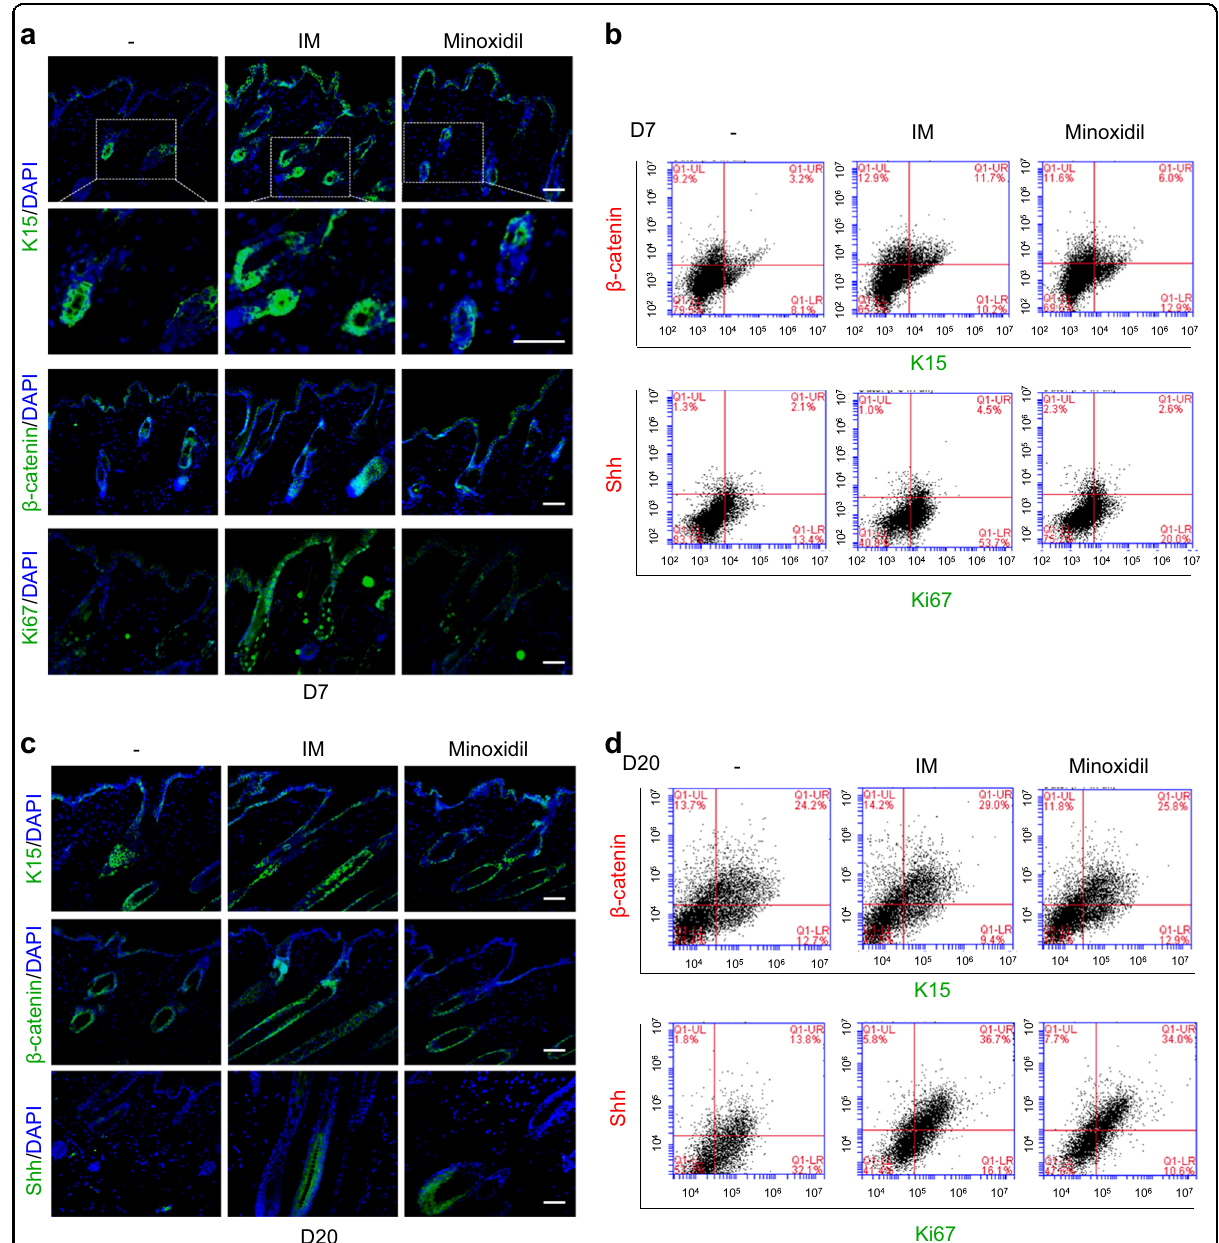
Fig. 5 IM promotes the expression of hair follicle cycling-related markers. a Immunohistochemistry of K15, β -catenin, and Ki67 in each treated mouse skin on day 7. Enlarged images of K15 in the top panels (dotted line) are shown in the second panels. b FACS analysis of K15/ β -catenin and Ki67/Shh in single cells of each treated mouse skin on day 7. c Immunohistochemistry of K15, β -catenin, and Shh in each treated mouse skin on day 20. d FACS analysis of K15/ β -catenin and Ki67/Shh in single cells of each treated mouse skin on day 20. DAPI staining was used to identify the nuclei (blue). Scale bar = 50 μ